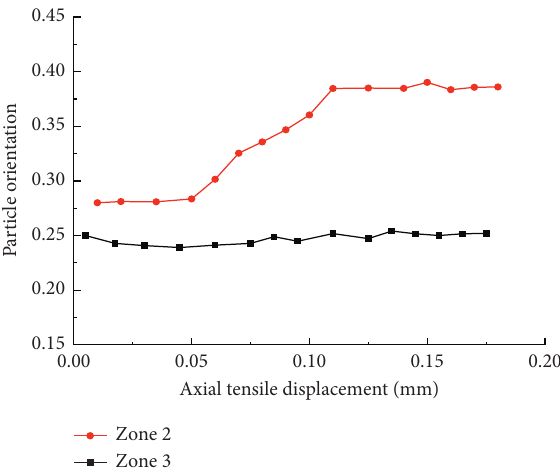
Figure 24: The change of particle orientation in Zone 2 and Zone 3.